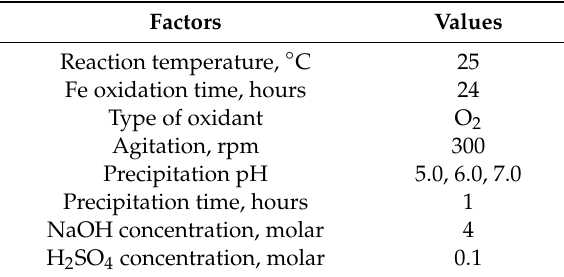
Table 1. Factors and values selected for co-precipitation of iron and aluminium .